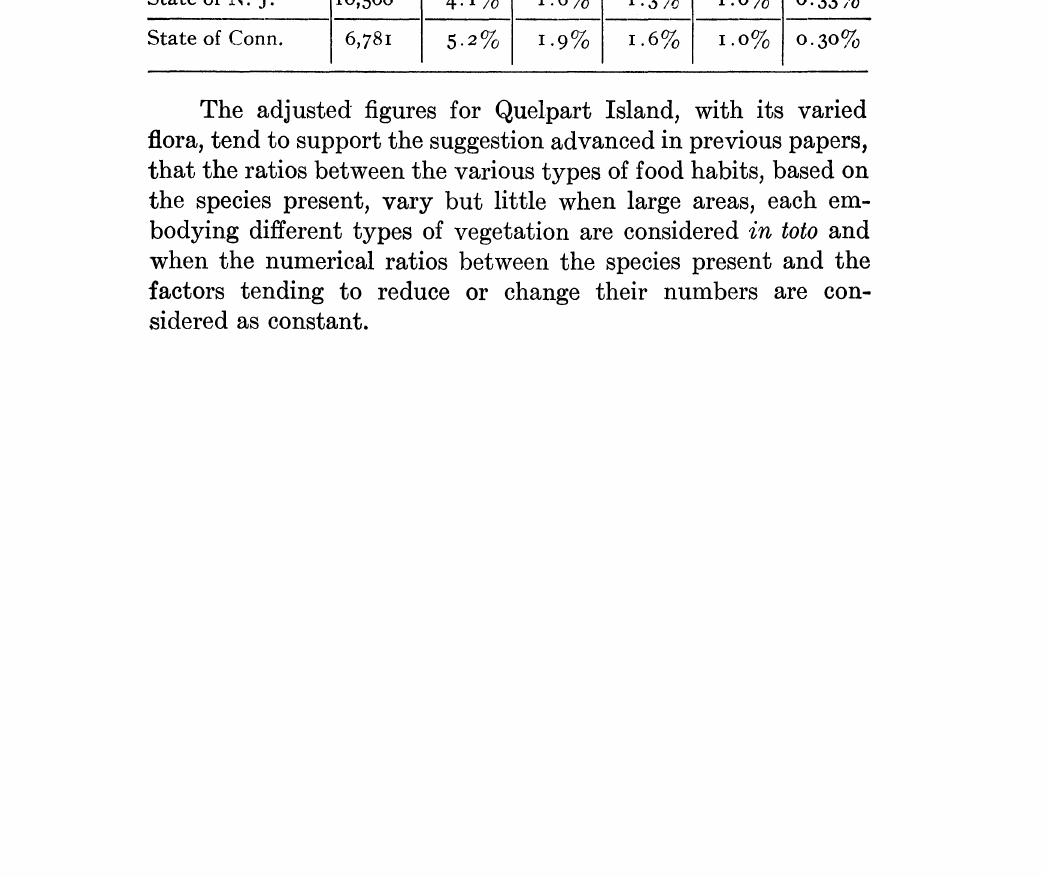
Quelpart Island V.estern Arctic Coast Of N. A. State of N. J. State of